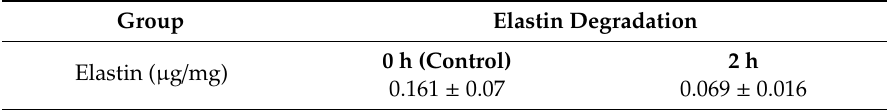
Table 5. Mean ± SEM elastin concentration in un-degraded and elastin-degraded porcine aortic valve leaflet specimens after 2 h of elastase exposure. (n = 3 samples /